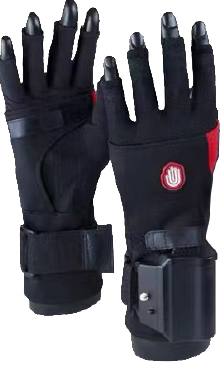
Figure 1. VR data